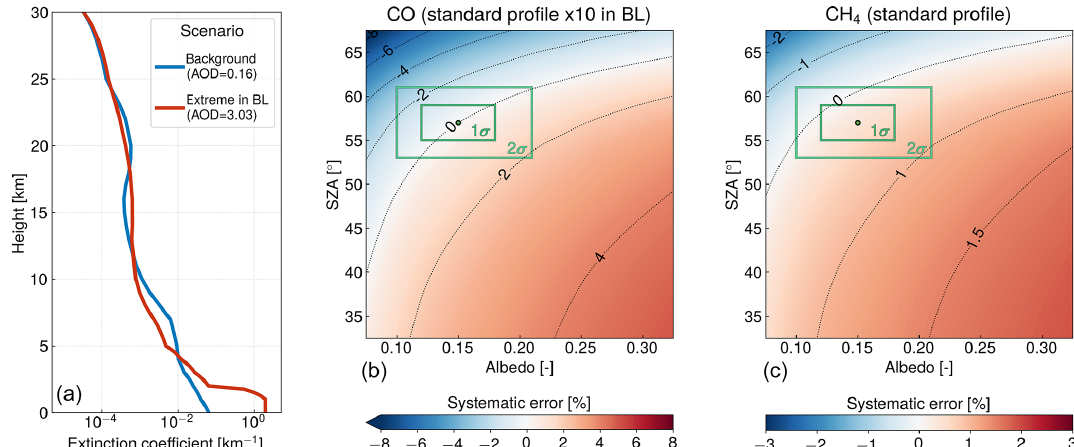
Figure 9. Panel (a) shows the aerosol extinction profiles used in the analysis of smoke aerosol errors. Also given are the corresponding aerosol optical depths at 550nm. The other panels show the systematic errors of CO and CH 4 as a function of solar zenith angle and albedo when using the extreme instead of the background aerosol scenario. The green boxes highlight the typical conditions for the Californian cities on the analysed days using percentiles corresponding to 1 σ (68% of data) and 2 σ (95% of data). The green circle is the pair of median albedo and median solar zenith angle.